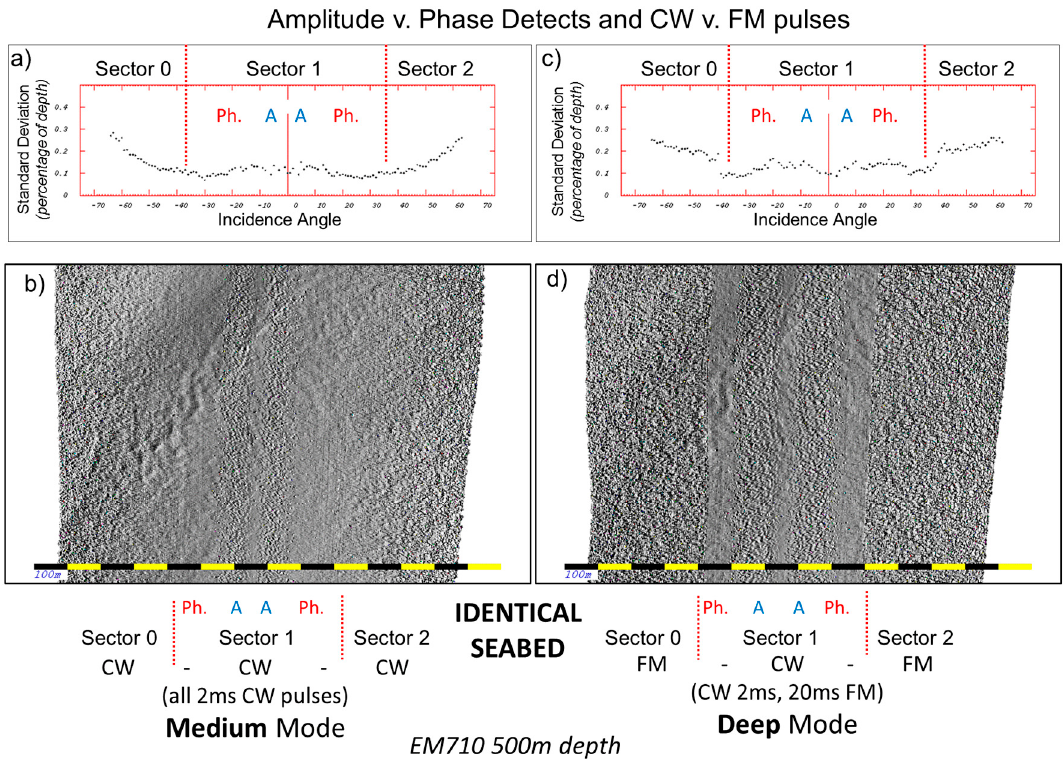
Figure 6. Illustrates the impact on changing from a CW to FM pulse on the identical seafloor. A terrain in ~500 m water depth is imaged by the same sonar sequentially with FM pulses turned on ( c , d ) and off ( a , b ). Frames ( b , d ) show a sun-illuminated representation of the data gridded at ~1% of the water depth. Frames ( a , c ) show derived sounding noise statistics (one standard deviation scaled by water depth) for the corresponding examples. The location of the sector boundaries is indicated. Ph: phase detection, A: Amplitude detection.